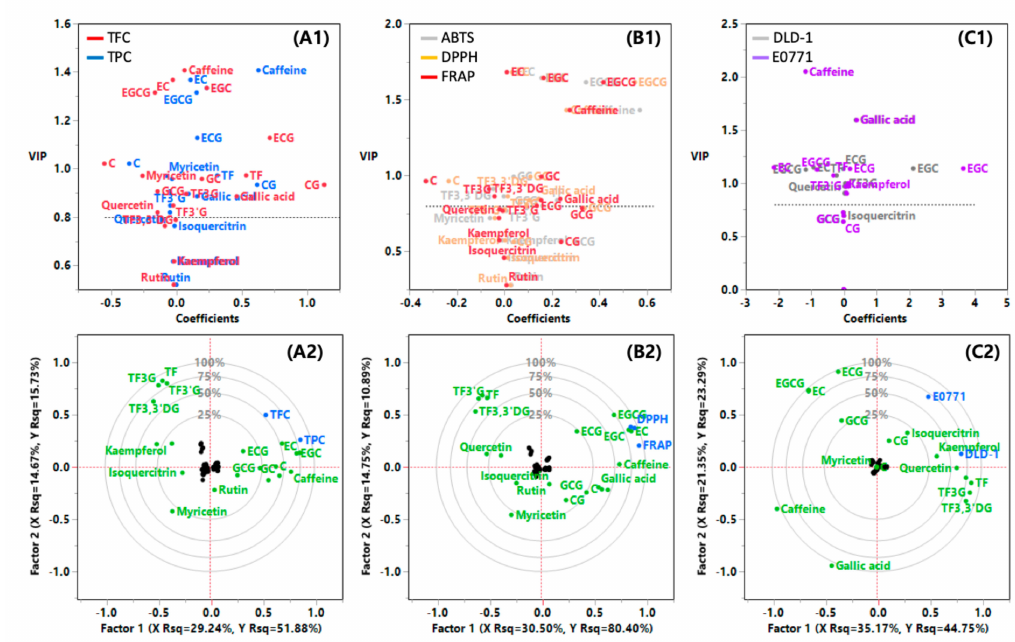
Figure 6. Partial least squares-discriminant analysis for the 20 compounds identified in five tea extracts and their biological e ff ects. ( A ) TFC / TPC, ( B ) antioxidant capacities, and ( C ) anticancer e ff ects. ( 1 ): VIP versus coe ffi cients matrix diagram for centered and scaled data and ( 2 ) correlation loading plots. Factor 1 and factor 2 are constructed to account for the correlation or covariance between the observed variables. Factor rotation was used to change the reference axes of the factors to increase their